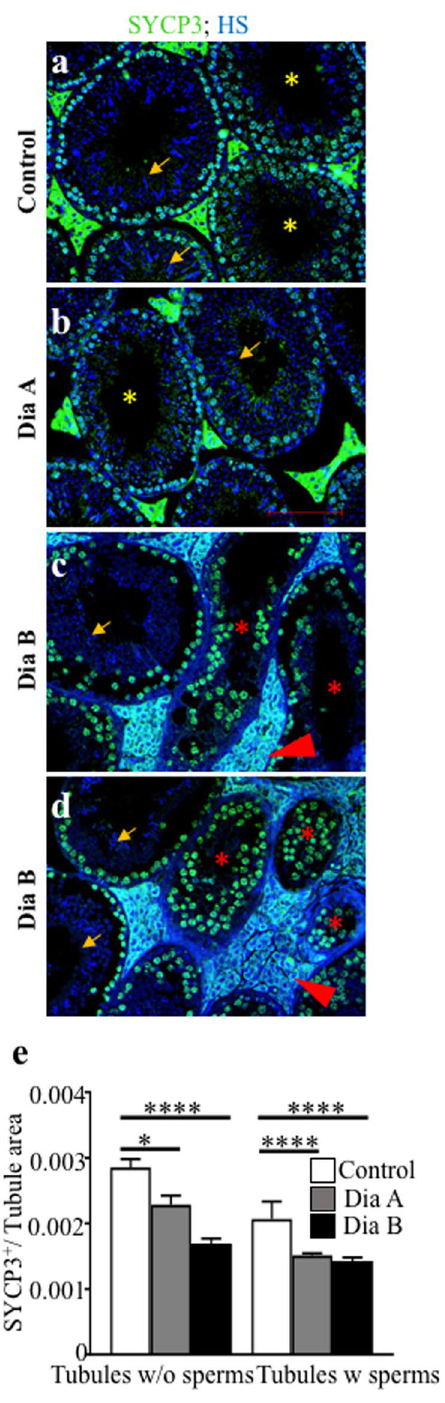
Figure 6. Decreased number of meiotic cells in diabetic testes as detected by SYCP3 marker. The representative images show the expression of SYCP3 (green) in various stages of spermatogenesis ( a – d ), nuclei are counterstained with DAPI (blue). Seminiferous tubules with mature spermatozoa (arrows) and without mature spermatozoa (yellow asterisks) are indicated. Abnormal accumulation of SYCP3 + spermatocytes in the seminiferous tubules of diabetic males is indicated by red asterisks. An expansion of amorphous material in the interstitial tissue is shown by red arrowheads. Scale bar 50 μ m. ( e ) A relative quantification using ImageJ program determines SYCP3 + cell area per tubule area. Tubules with and without mature spermatozoa are evaluated separately. The values represent means ± SEM ( n = 3 individuals/3 sections/31 areas/control group; 49 areas/Dia A group; 39 areas/Dia B group). * P < 0.05, **** P < 0.0001 vs . Control by Dunnett’s post hoc